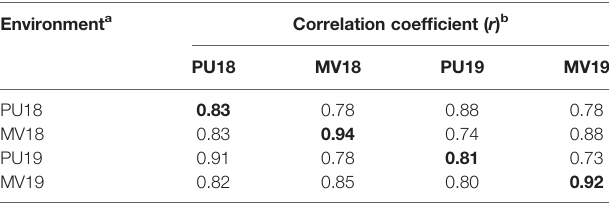
TABLE 1 | Correlation coef fi cients ( r ) of stripe rust infection type (IT) and disease severity (DS) across four